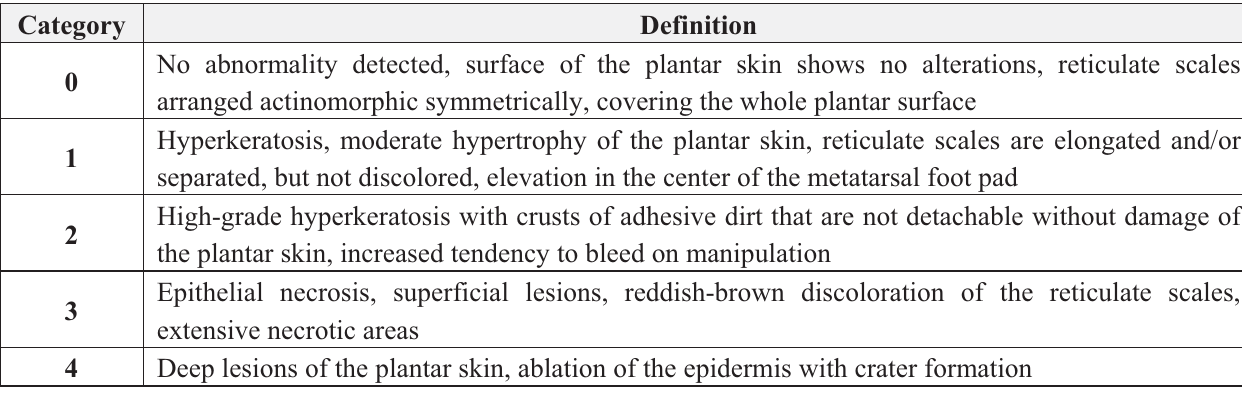
Table 1. Categories used to describe food pad